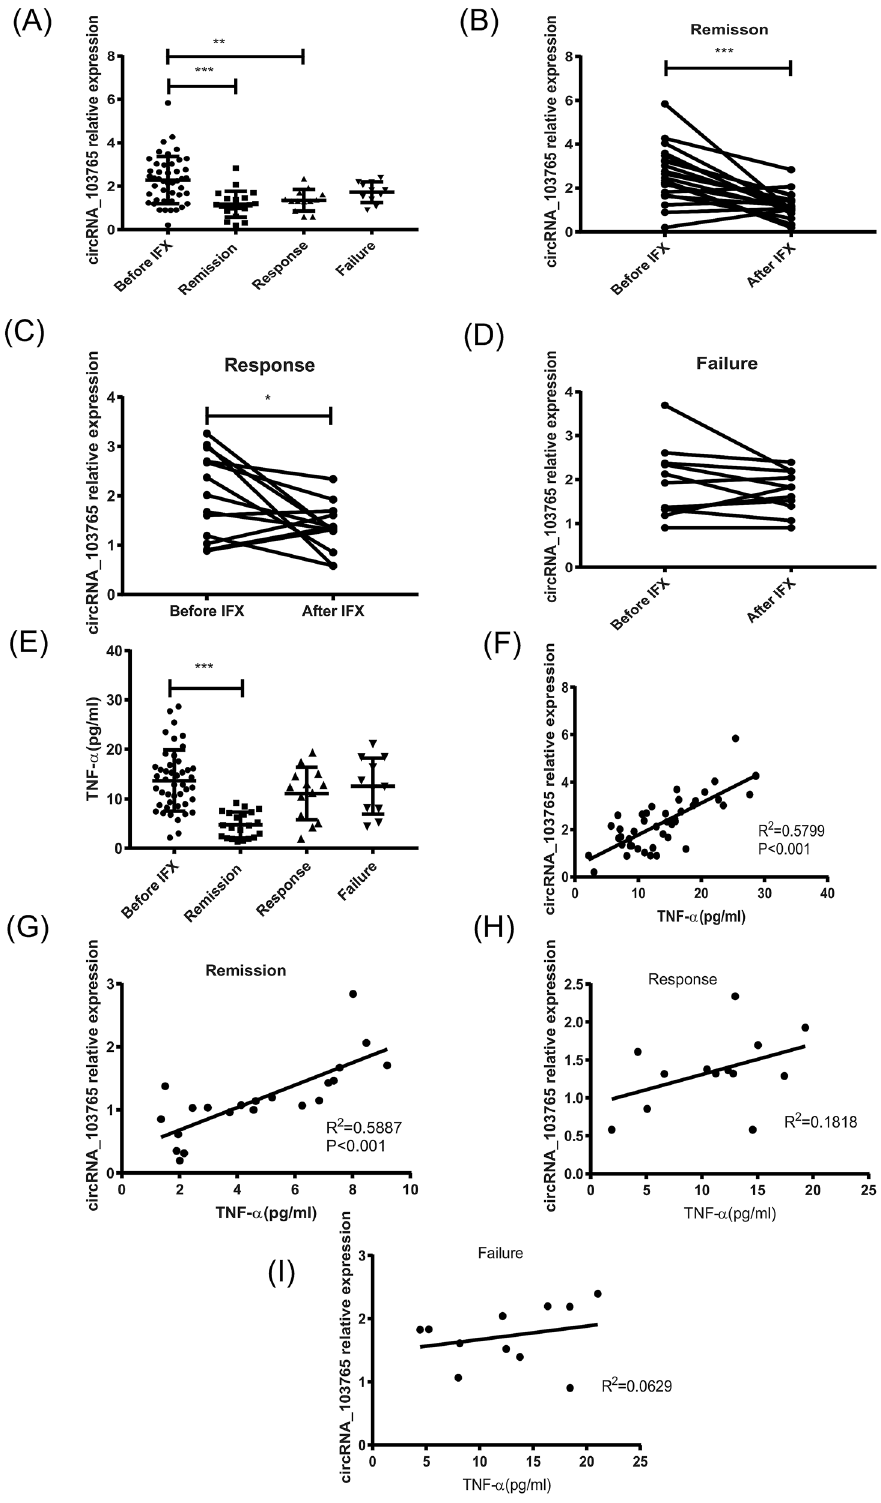
Figure 2. The effect of IFX therapy on circRNA_103765 and TNF α expression in PBMCs from active CD patients. ( A ) Forty-five active Crohn’s disease (CD) patients received treatment with Infliximab (IFX) as indicated, the changes of circRNA_103765 expression from the remission (n = 21), response (n = 13) and failure (n = 11) groups were analysed. ( B – D ) circRNA_103765 expression in PBMCs from 45 active CD patients prior to and after IFX treatment. ( E ) The changes of TNF-α expression from the remission (n = 21), response (n = 13) and failure (n = 11) groups were analysed. ( F – I ) Correlations analysis were performed between the levels of TNF-α and circRNA_103765 expression in 45 patients with active CD prior to IFX treatment ( F ) and in clinical remission group ( G ), in the response ( H ) and the failure group ( I ) after IFX treatment ( G ). *p < 0.05, **p < 0.01, ***p <